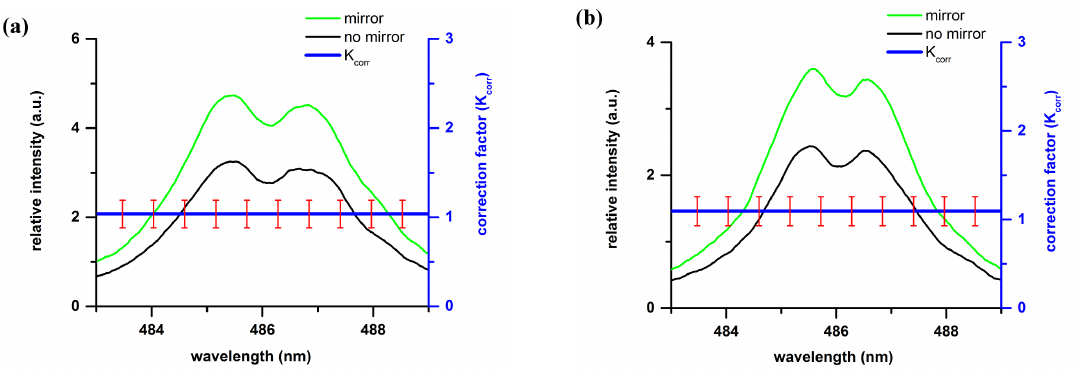
Figure 12. Measured, Savitzky–Golay filtered H β air-plasma data with and without using a doubling mirror [33]. The correction factor, K corr , is almost equal to 1. The error bars indicate the estimated errors in determination of the correction factor. Time delay: ( a ) 5 µ s; and ( b ) 7 µ